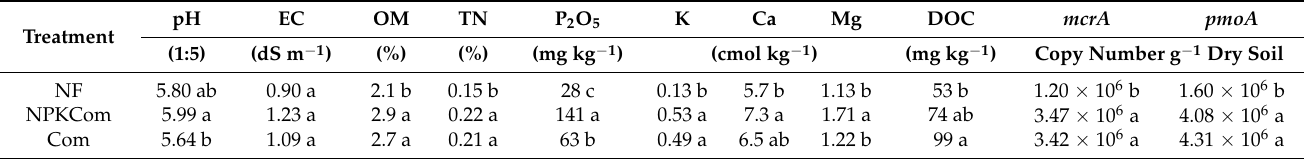
Table 2. Soil chemical properties and abundance of methane cycling related genes of long-term compost-fertilized paddy